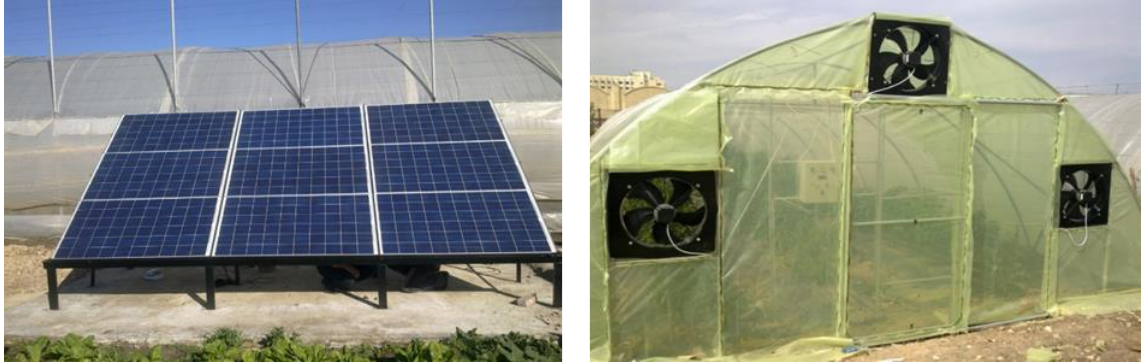
Figure 1. Solar energy cells used in the experiment ( left ), front side of the walk-in tunnel with evaporative cooling system ( right ). evaporative cooling system ( right